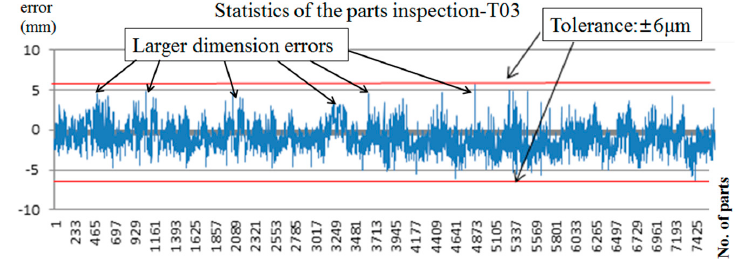
Figure 22. Statistics of parts inspection for T03.